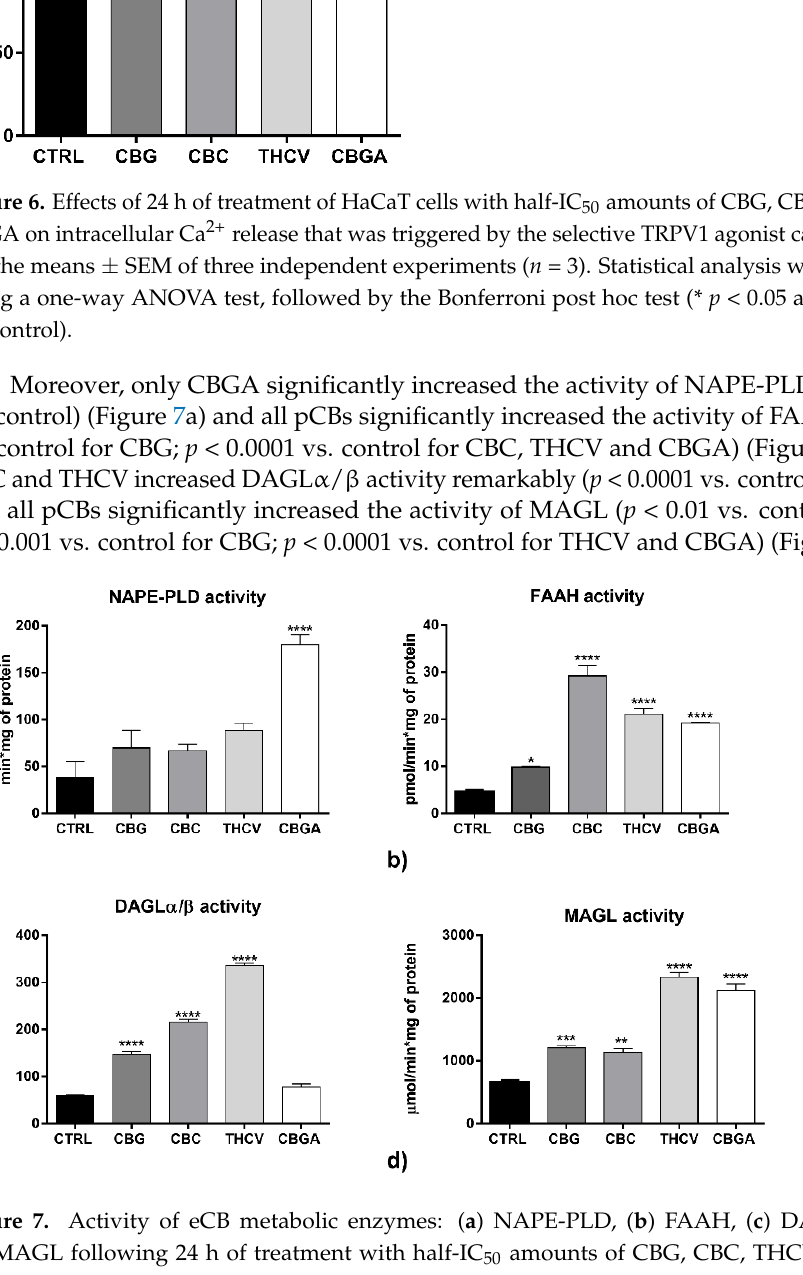
Table 4. Activity ratios of NAPE- PLD/FAAH and DAGLα,β/MAGL with respect to the control (control was set to 1.00). Data are from Figure 7 (* p < 0.05 and *** p < 0.001 vs. control).